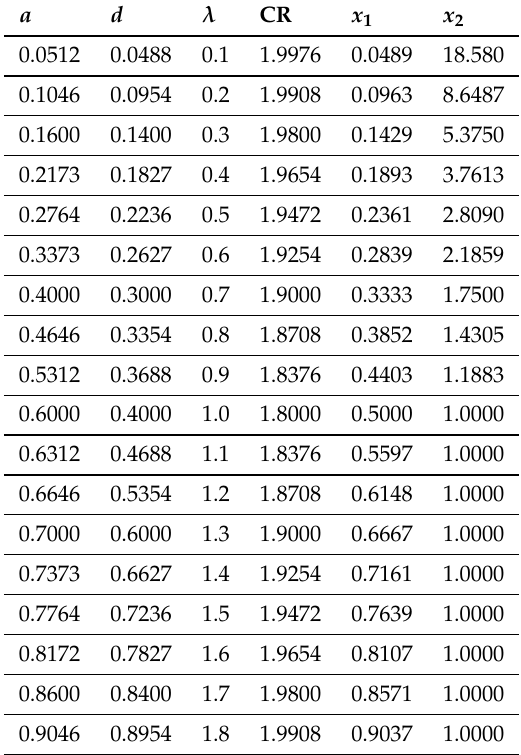
Table 2. Best competitive ratios (CR) together with the corresponding online algorithm for that ratio (defined by switching time values x 1 and x 2 ) for given parameter value λ .